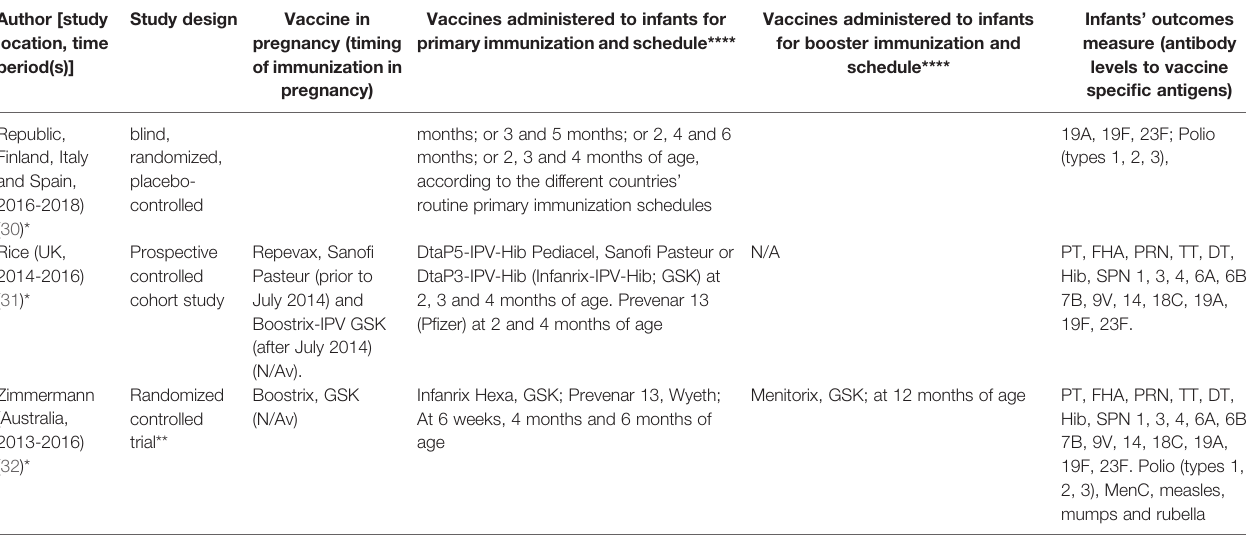
compared with infants of women who did not receive Tdap in pregnancy post-primary, pre-booster and post-booster